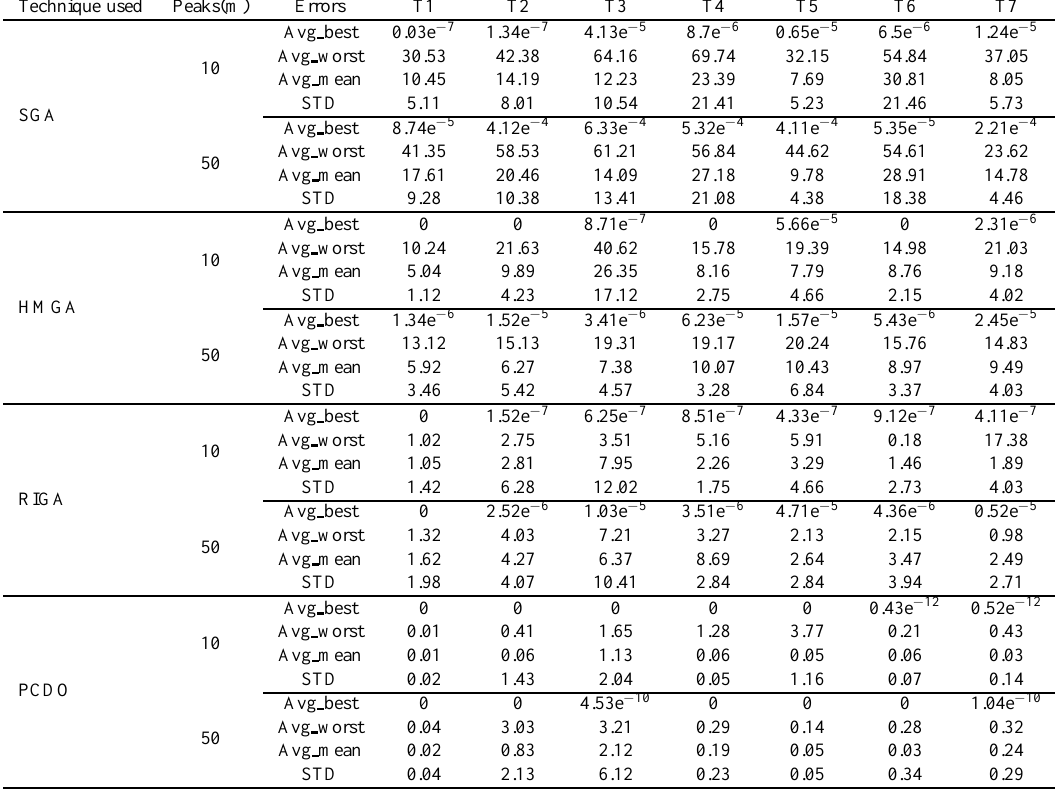
Table 1. Error Values Achieved for Problems F 1 .